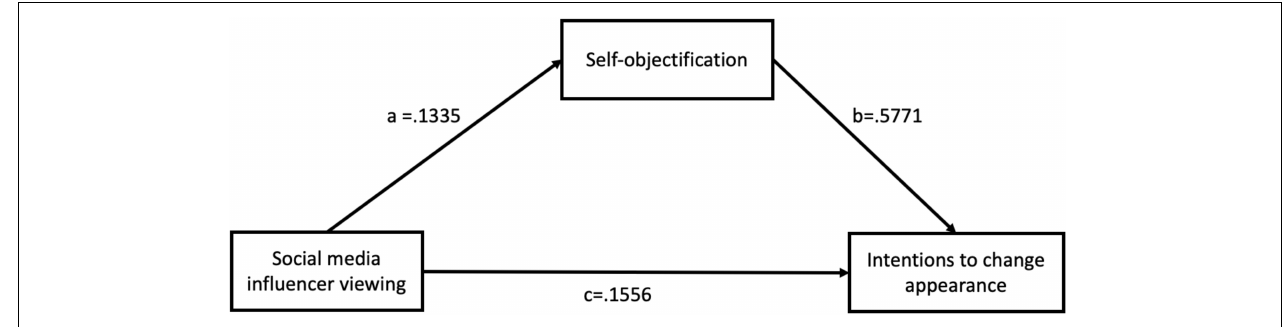
FIGURE 1 | Social media influencer viewing predicting intentions to change appearance through self-objectification as the mediator.